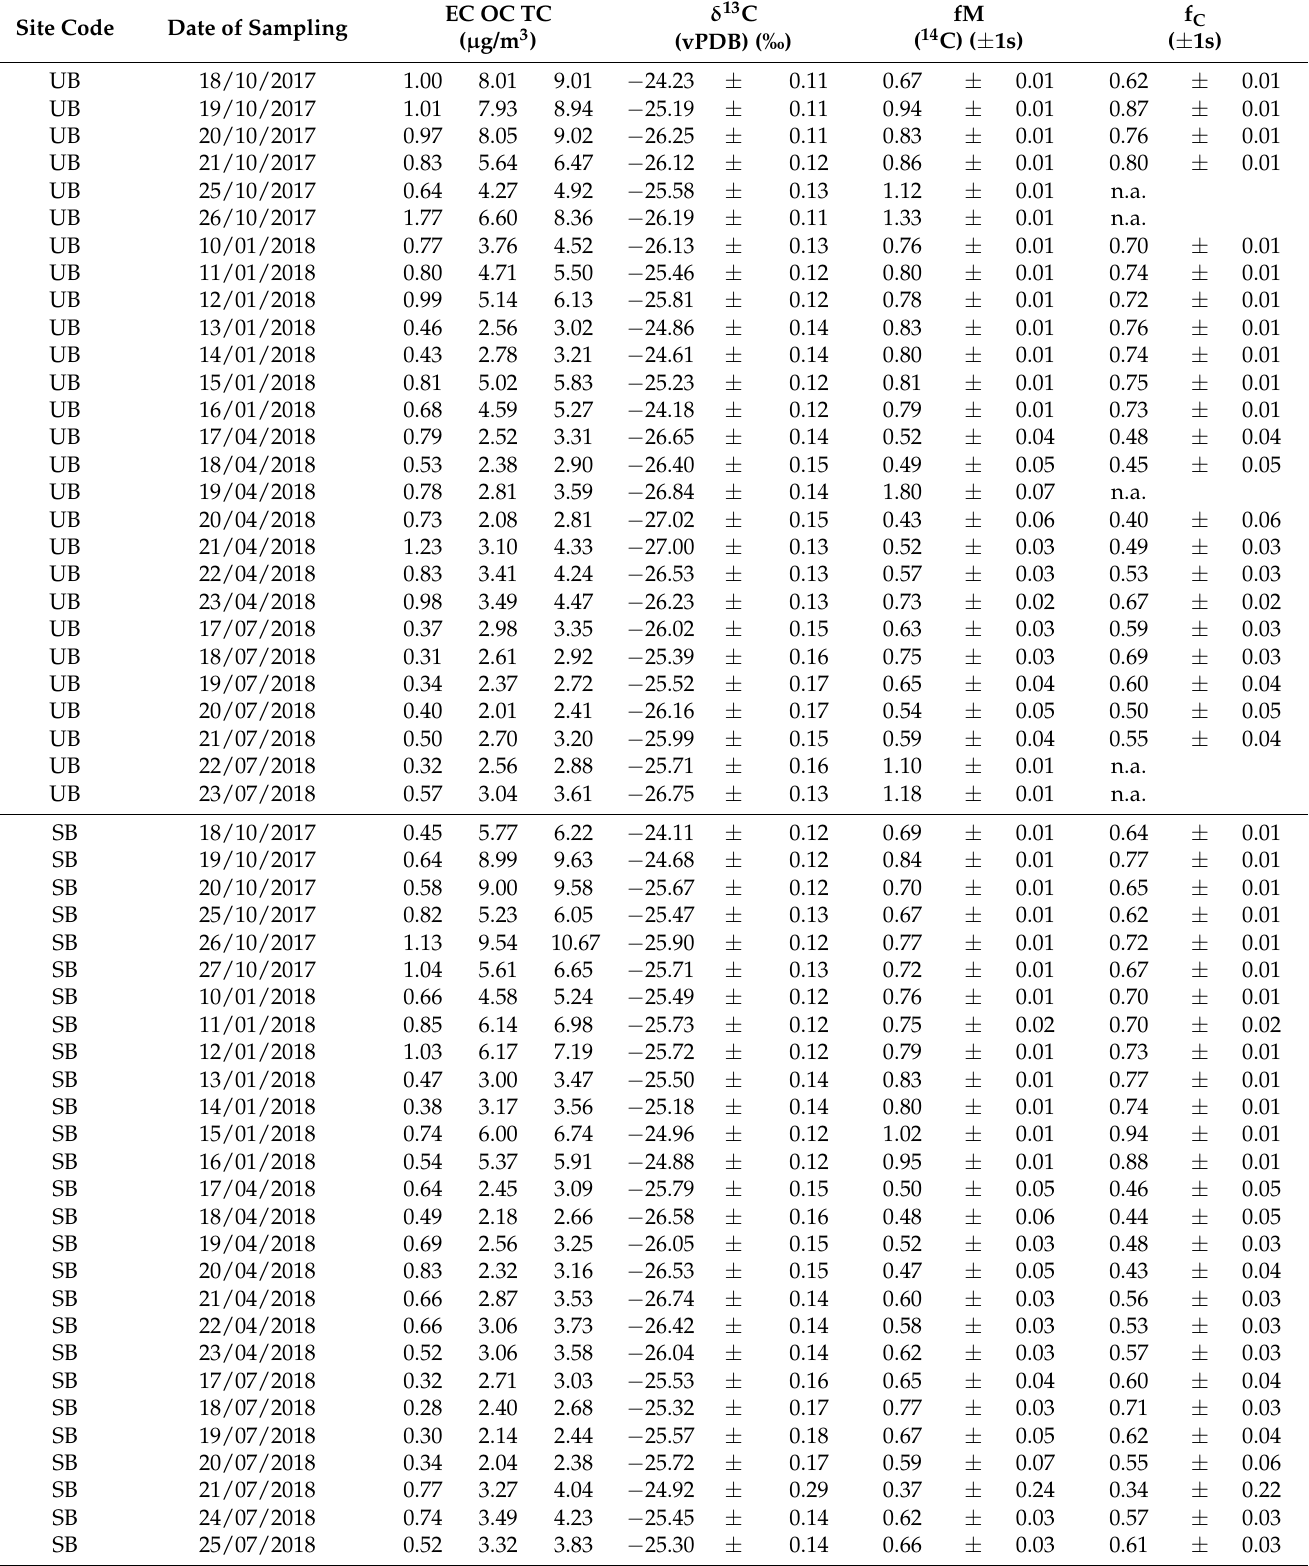
Table A1. Measured carbon concentration and isotope